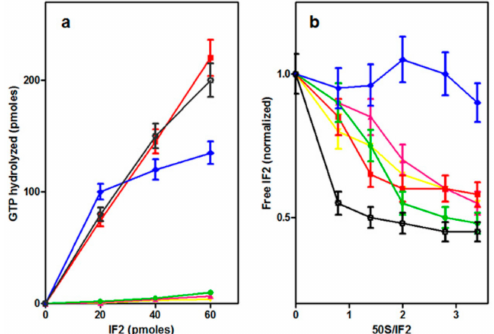
Figure 4. Ribosome-independent GTP hydrolysis by IF2. ( a ) GTP hydrolyzed (ordinate) in the presence of increasing amounts (abscissa) of the individual IF2 variants. The reaction mixtures and conditions were identical to those described in the legend to Figure 3 but for the fact that the ribosomal subunits were omitted and replaced by 20% ethanol; ( b ) interaction between increasing amounts of G. stearothermophilus 50S ribosomal subunits and a fixed amount of the individual IF2 variants so as to obtain the 50S / IF2 stoichiometric ratios indicated in the abscissa. After incubation for 10 min at 45 ◦ C the mixtures were subjected to ultracentrifugation and the amount of free (not 50S-bound) IF2 present in the post-ribosomal supernatant determined as described in Materials and Methods. The results are normalized with respect to the amount of each IF2 variant present in the absence of 50S subunits which is taken as = 1. The symbols in both panels correspond to: wtIF2